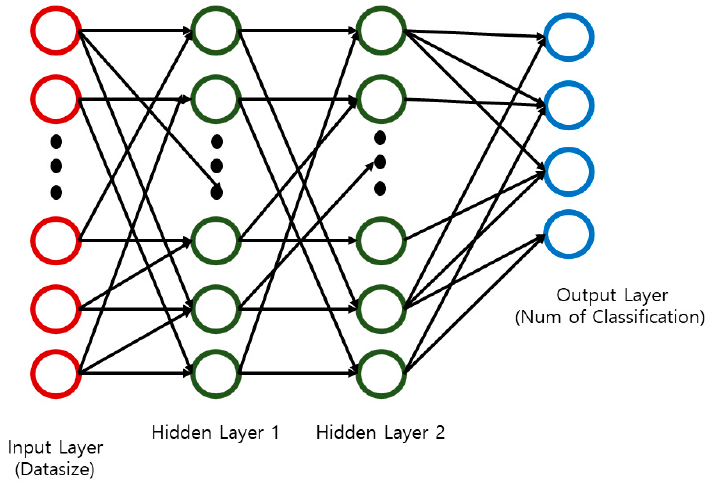
Figure 4. An artificial neural networks (ANNs) model.